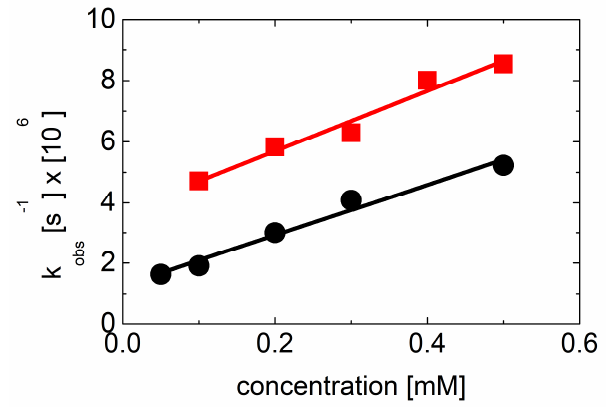
Figure 6. Plots of the observed pseudo-first-order rate constants of the formation of the 370 nm absorption as a function of 3-MeQ (●) and 7-CN-3-MeQ ( ) concentration in N 2 O-saturated aqueous solutions at pH = 7 containing 0.01 M NaN 3.